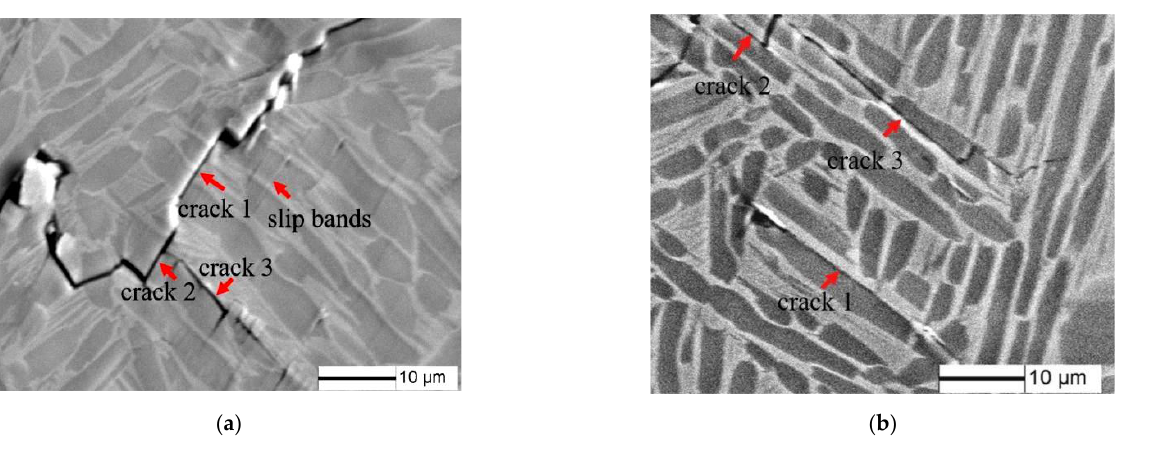
Figure 9 . Morphology of secondary crack initiation on the side of fatigue specimen under different stress amplitudes. ( a ) 1000 MPa. ( b ) 950 MPa.